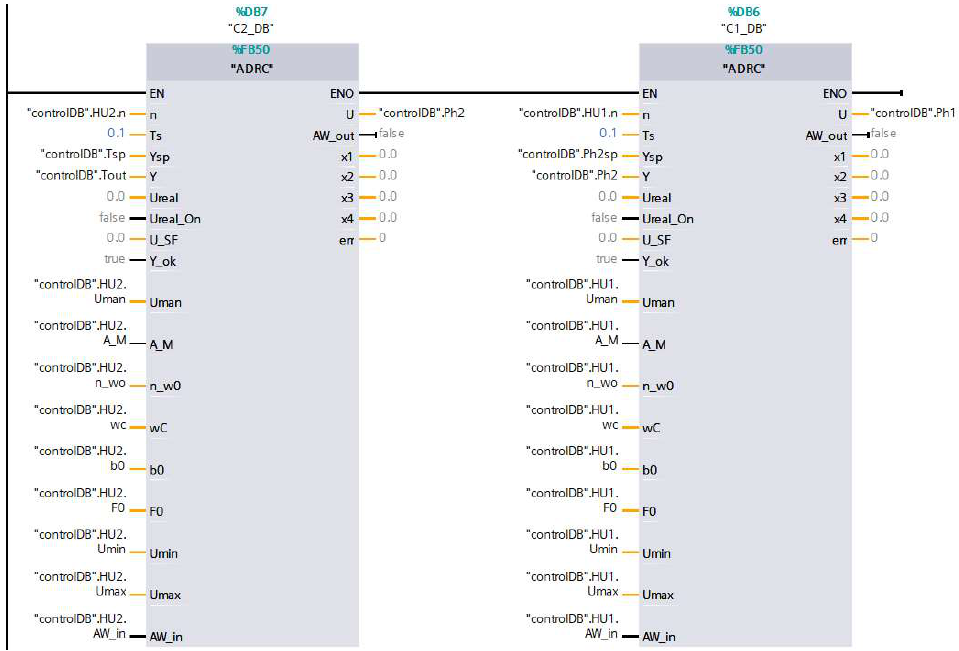
Figure 6. Schematic diagram of the PLC-based implementation of the control program representing the proposed ADRC-based habituating control structure.